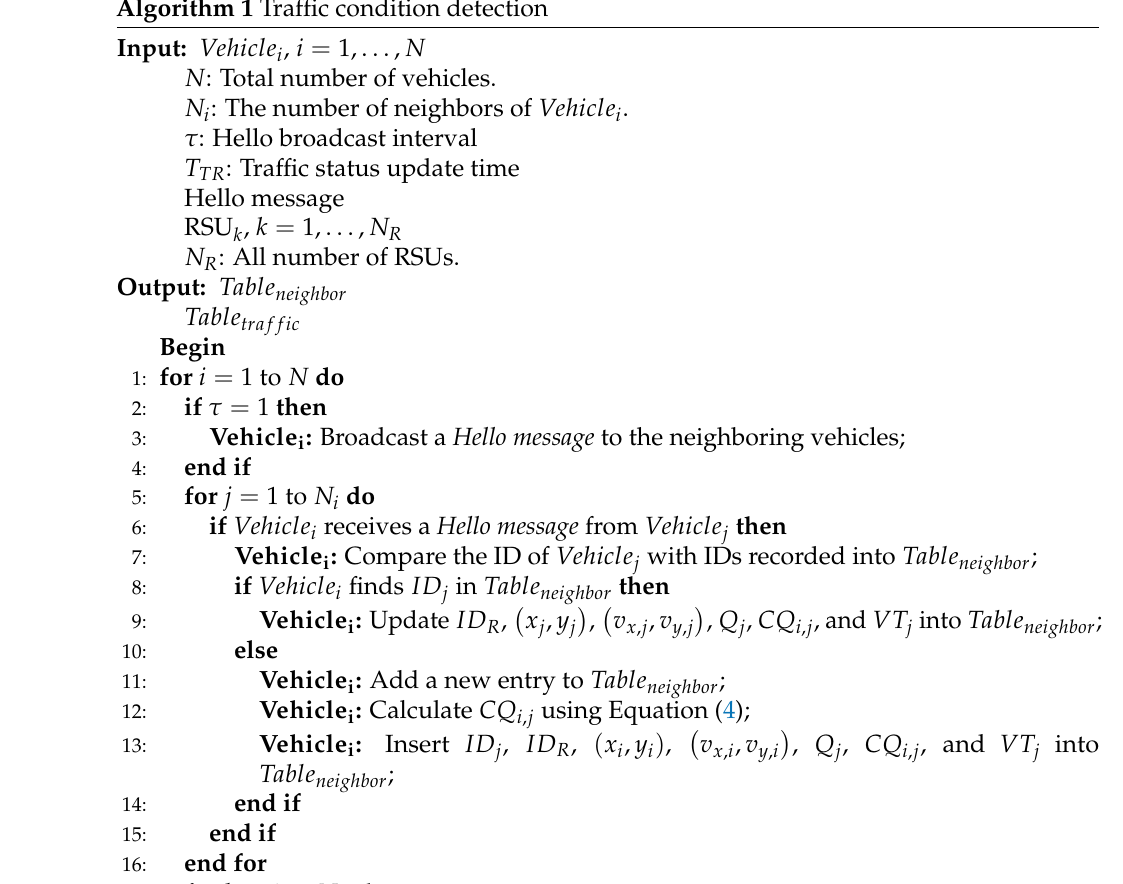
Algorithm 1 Traffic condition